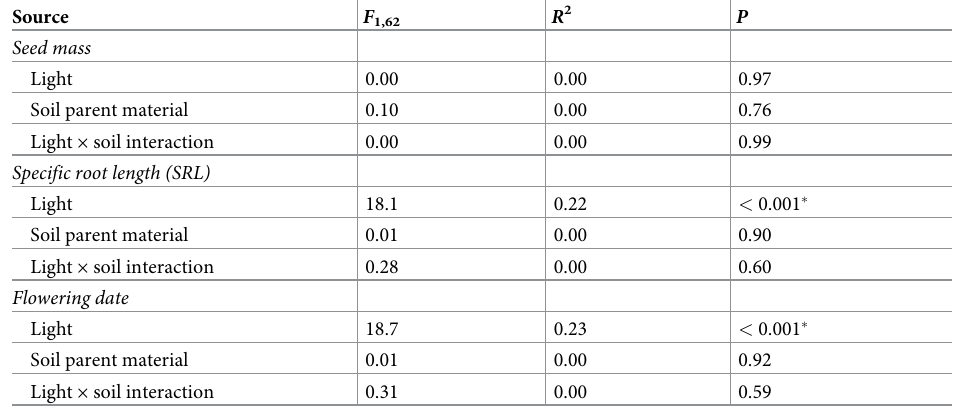
Table 3. Results from a two-way PerMANOVA with light (sun, shade), parent material (basalt, limestone), and their interaction as factors influencing resulting community-weighted mean trait values in the